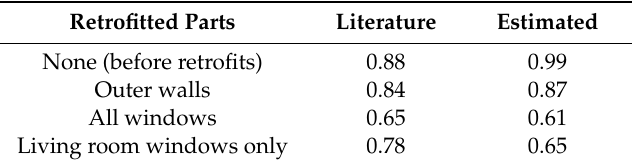
Table 5. Summary of identified Ua values before and after retrofits. The median of estimation results for Ua values (W / m 2 K) for di ff erent cases of retrofits (none, outer walls, all windows, living room windows only) is represented for three-room